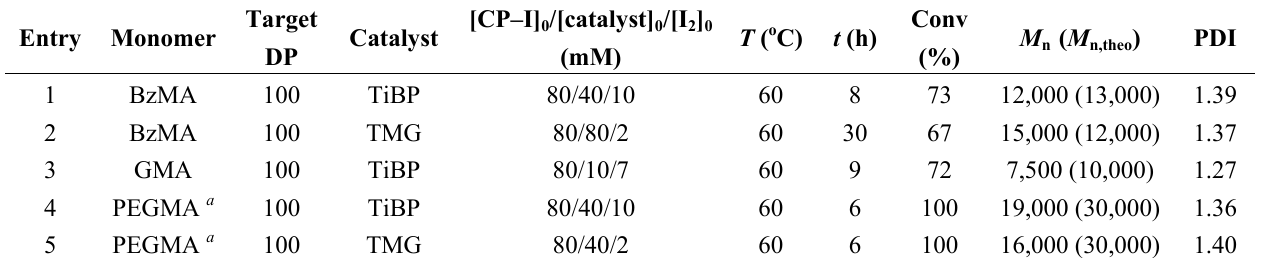
Table 2. Polymerizations of Functional Methacrylates (in